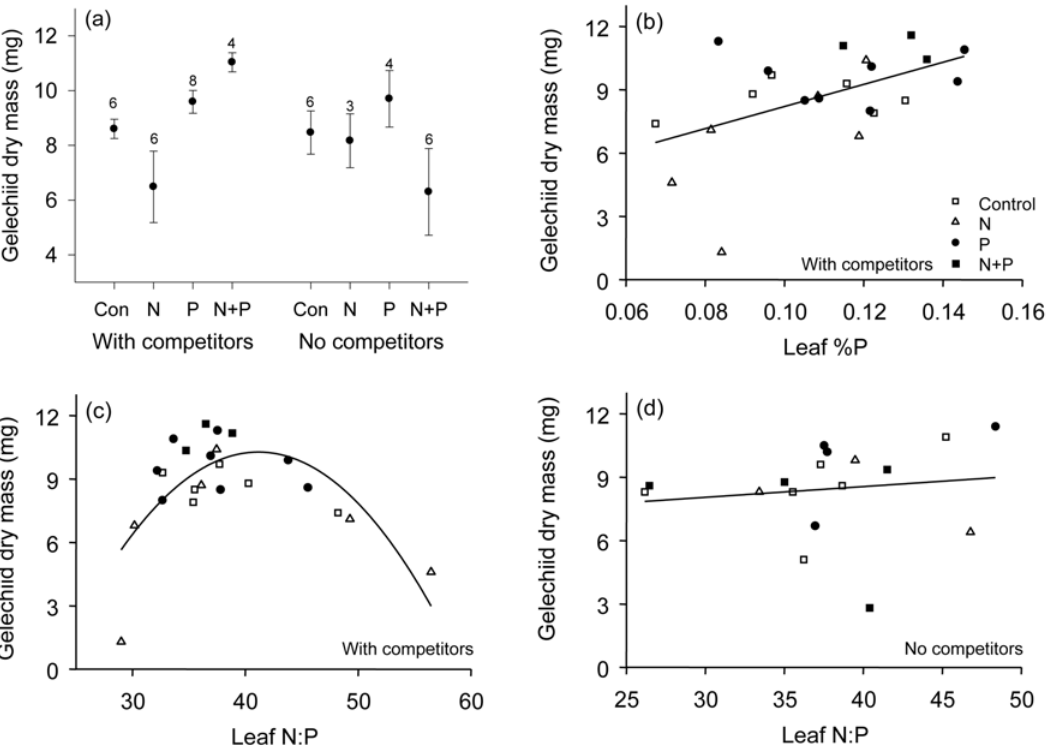
Figure 2. Greenhouse fertilization and competition treatments. a) Treatment effects on larval dry mass (mean 6 SE, n is shown above each point) at 46 days. There are significant effects of P and N 6 P 6 competition. Panels b–d: The effects of leaf (N:P) 2 and %P on larval dry mass at 46 days are highly significant ( P , 0.0001; P =0.002; Table 1) with grass competitors (b,c) but not without competitors (d). The legend in (b) applies to (c) and